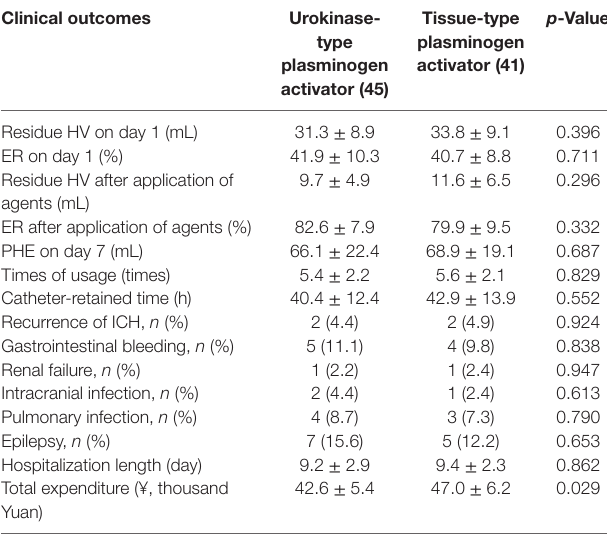
TaBle 2 | Short-term outcomes within 30 days postoperation. clinical